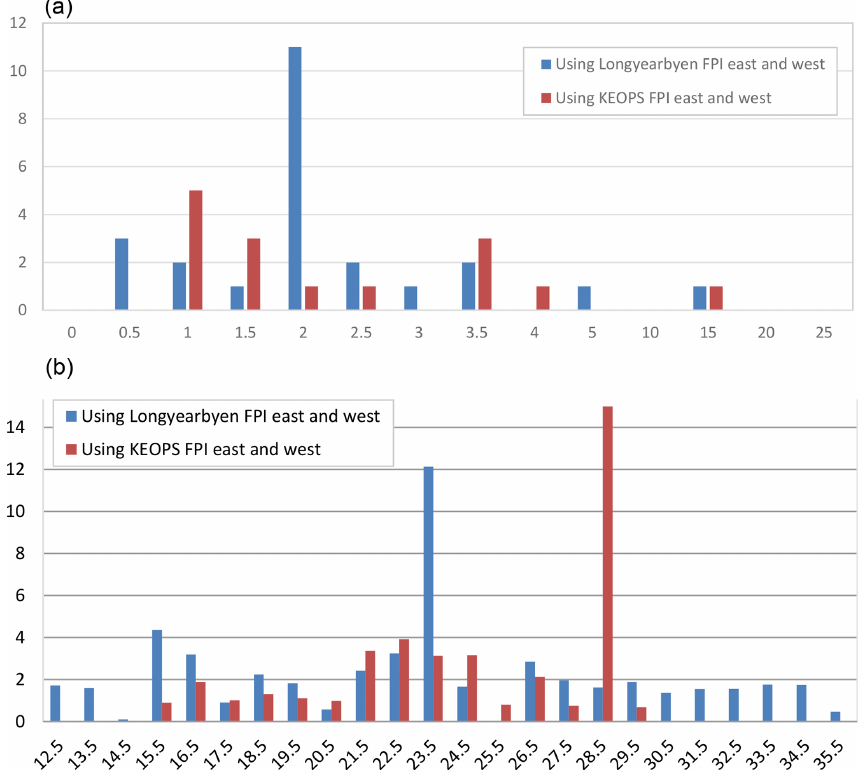
Figure 10. Frequency distribution of the ratios of CHAMP/FPI 1h averaged zonal wind magnitudes observed in the winter period for solar max under moderately active conditions (2 − ≤ Kp<4 + ) for Longyearbyen (blue) and KEOPS (red). Panel (a) shows the frequency distribution of the CHAMP/FPI ratios. Panel (b) shows the UT dependence of the